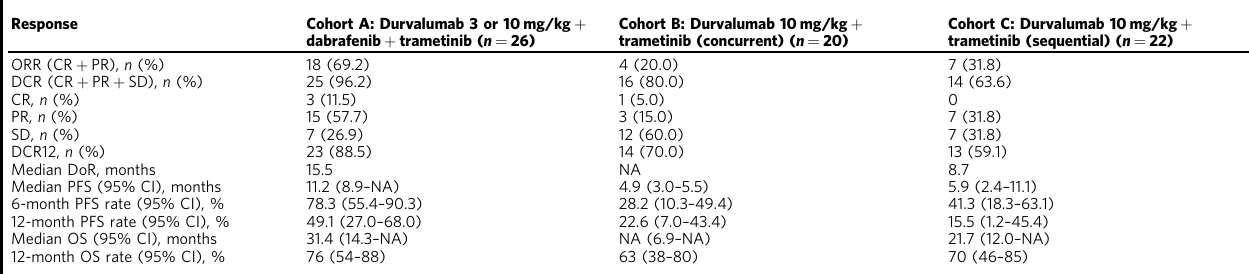
Table 3 Clinical activity (as-treated population).